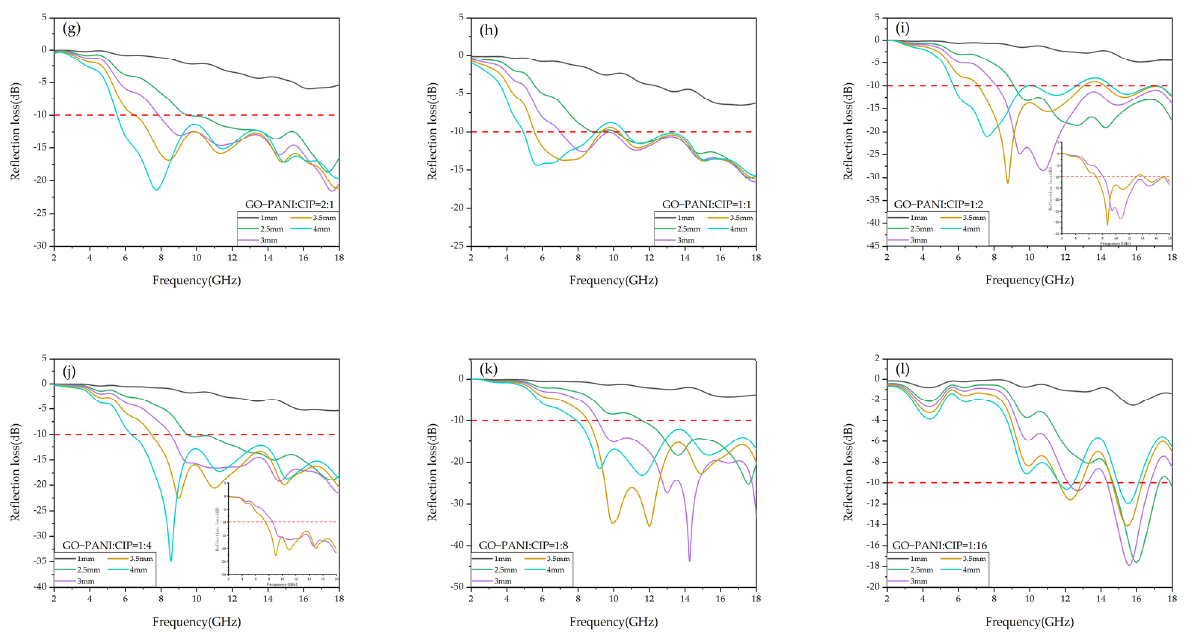
Figure 8. RL curves of ( a ) GO, ( b ) PANI, ( c ) GO − PANI, ( d ) CIP, ( e ) GO − PANI:CIP = 8:1, ( f ) PANI:CIP = 4:1, ( g ) GO − PANI:CIP = 2:1, ( h ) GO − PANI:CIP = 1:1, ( i ) GO − PANI:CIP = 1:2, ( j ) GO − PANI:CIP = 1:4, ( k ) PANI:CIP = 1:8 and ( l ) GO − PANI:CIP = 1:16.